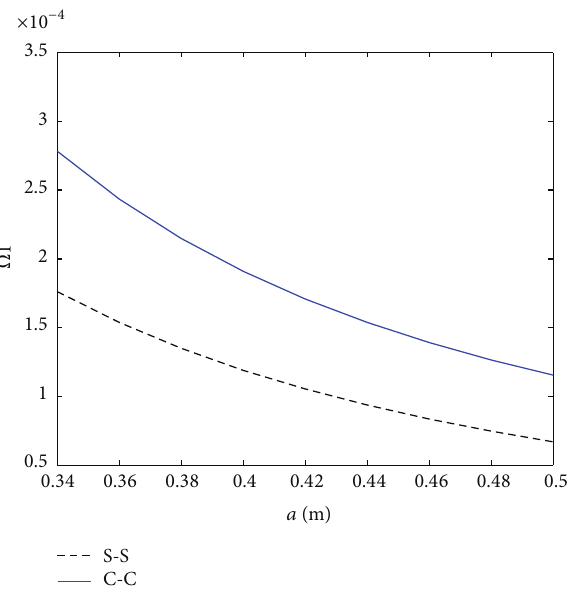
Figure 11: Variation of the first mode natural frequency with the radius of the plate with different boundary conditions ( 𝑏 = 0.05 m and ℎ 𝑐 = 0.0005 m).